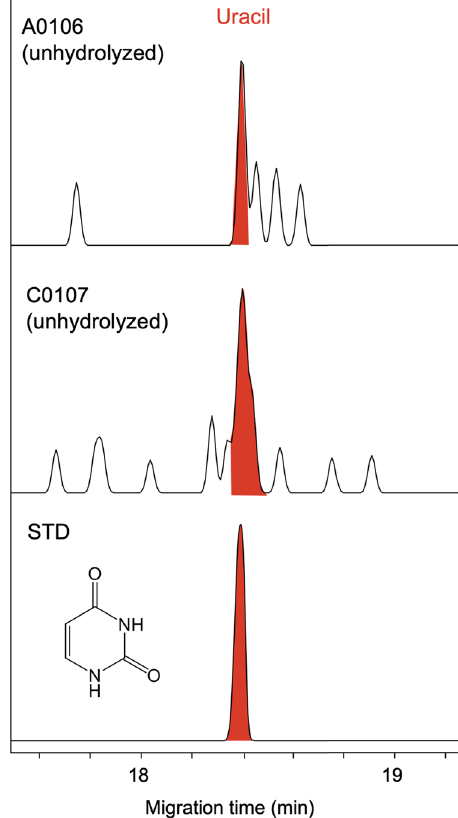
Fig.5|UracilinthehotwaterextractsfromtheRyugusamples. Cross-validation and high-resolution molecular identi fi cation of uracil obtained from hot water extracts (unhydrolyzed fraction) for Ryugu A0106 and C0107 by using capillary electrophoresis(CE)coupledwithhighresolutionorbitrapmassspectrometry(CE- HRMS).Datafortheauthenticstandardisalsoshownforcomparison.Thesignalof red color represents uracil on the migration time (18.4min).